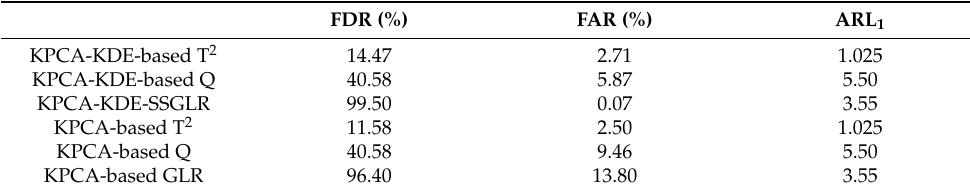
Table 1. Summary of fault detection